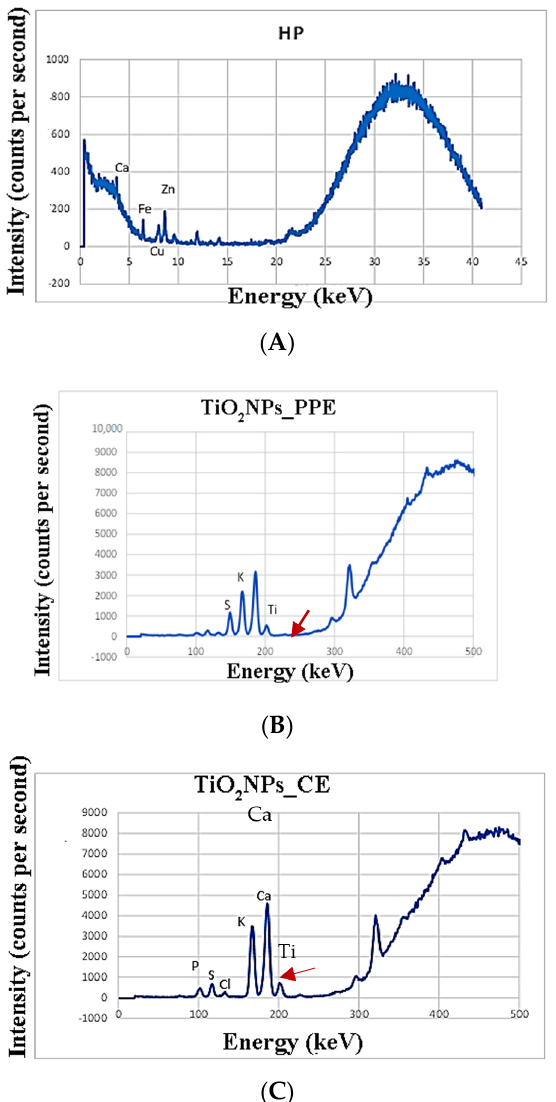
Figure 7. Analysis of P. granatum L. seeds treated with TiO 2 NPs using X-ray fluorescence spectroscopy (XRF), compared with hydroprimed seeds. ( A ): Hydroprimed seeds (HP); ( B ): seeds primed by TiO 2 NPs_PPE; ( C ): seeds primed by TiO 2 NPs_CE. Arrows indicate Ti signal in nanoprimed seeds.